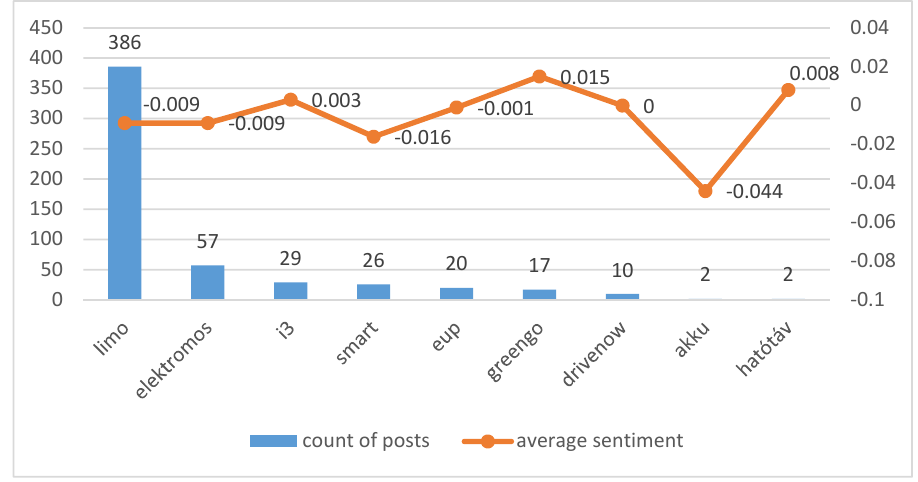
Figure 11. Number of mentions of terms in MOL car sharing Facebook group and their sentiment scores.